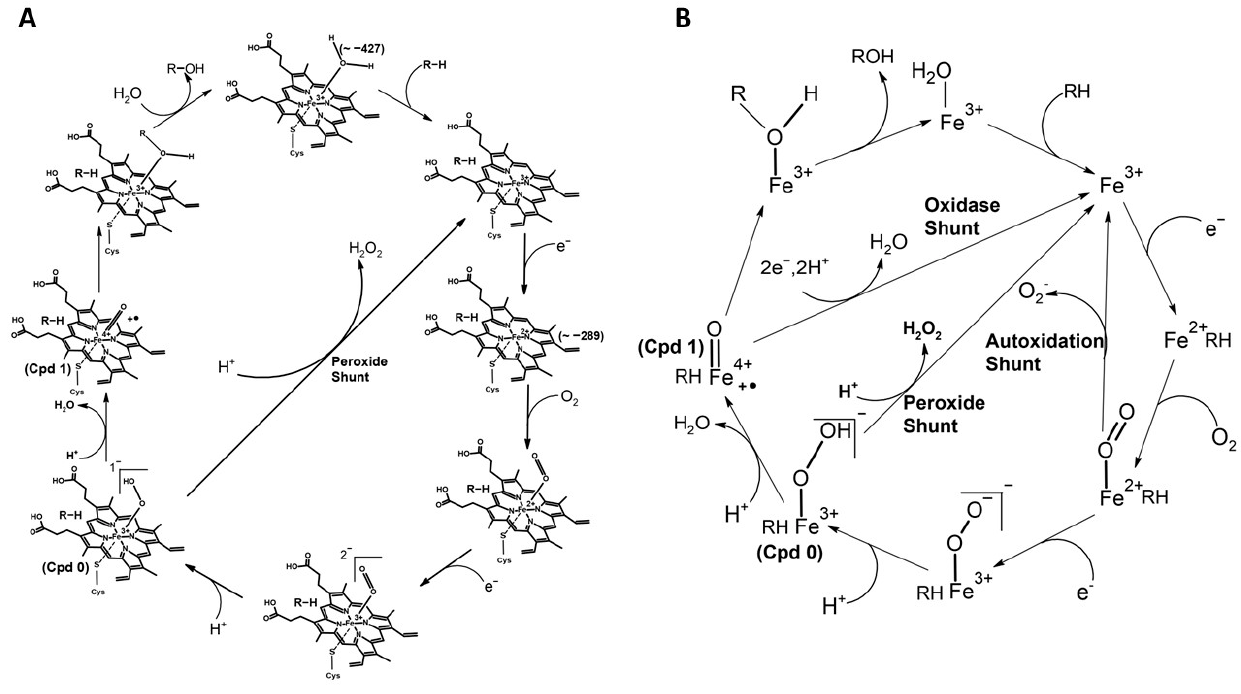
Figure 2. The schematic representation of the catalytic cycle of cytochrome P450. ( A ) The species (Compound 0 and Compound 1) are indicated. The species’ redox potential (mV) is given in the bracket. The axial heme ligand (cysteine thiolate, indicated as an S-atom linked to iron) and distal ligand (a water molecule that changes as the cycle progresses) are also indicated. ( B ) Uncoupling reactions with different pathways leading to the collapse of the oxy-intermediate are indicated. The oxy-ferrous form can reform the ferric state by superoxide formation via autoxidation shunt path- way. ‘Compound 0 ′ disintegrates with the production of peroxide and forms the ferric state (Sub- strate Bound) through peroxide shunt pathway.